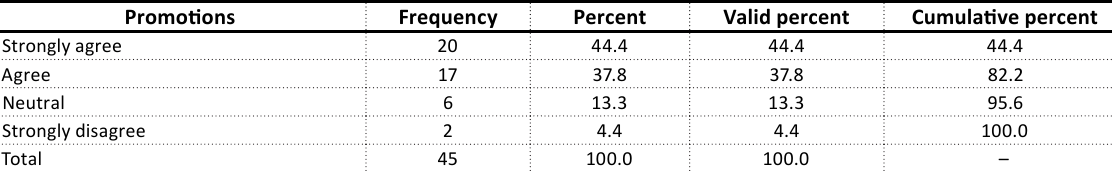
Table 12. Frequency showing the